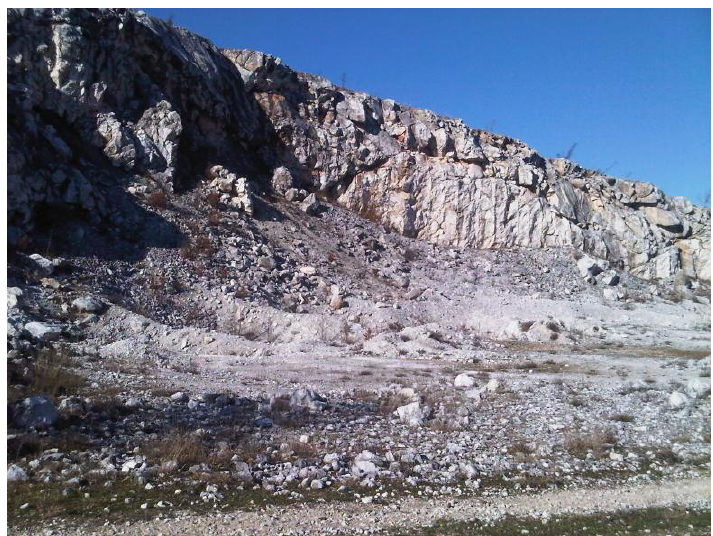
Figure 6. Vertical face of the quarry at Mikro Derio.